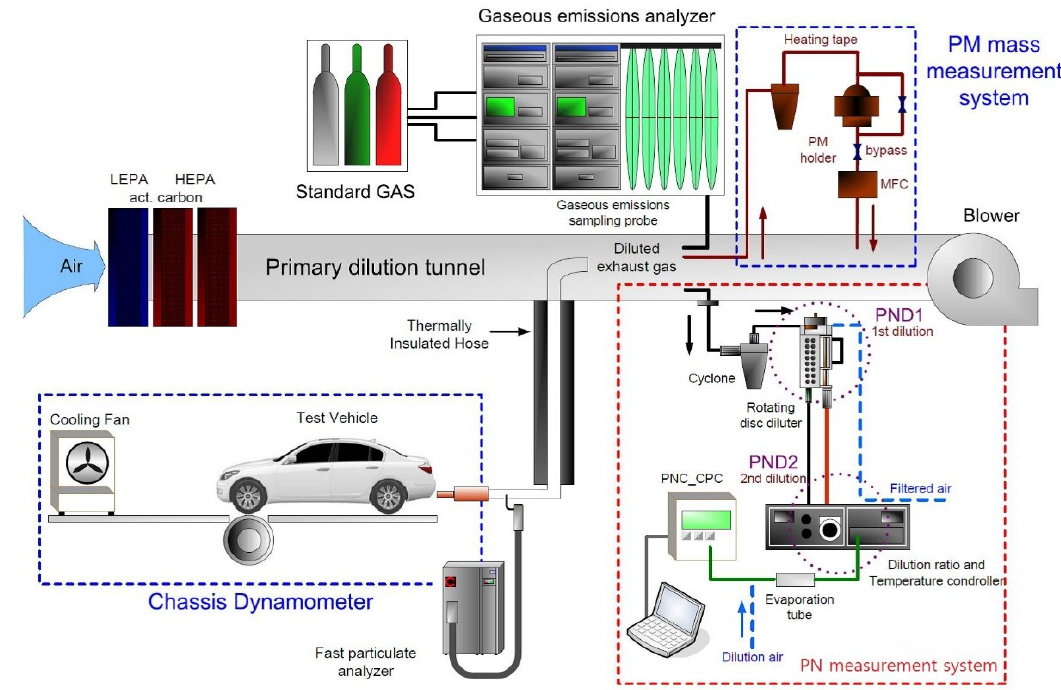
Figure 2. Schematic diagram of the vehicle test